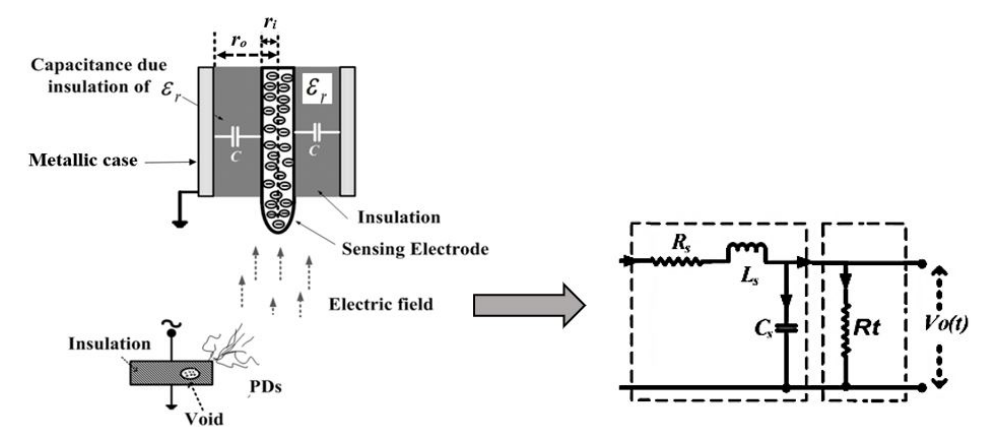
Figure 5. D -dot sensor ( a ) Sensor’s head ( b ) Sensor mounted on metal plane.